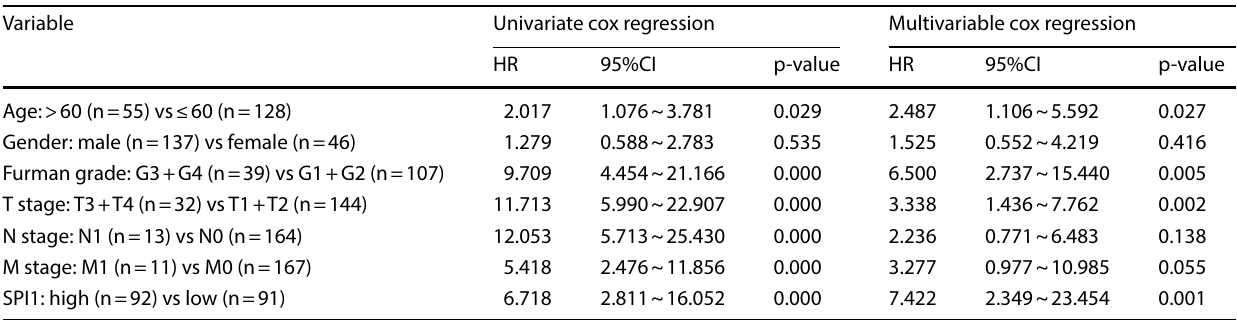
Table 2 Univariate and multivariable cox regression of SPI1 expression for progression-free survival in patients with